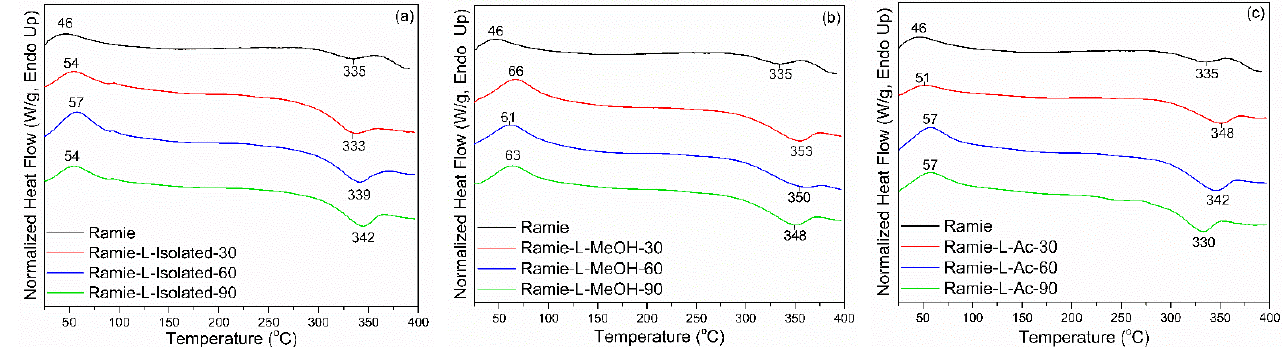
Figure 14. DSC analysis of impregnated ramie fibers: ( a ) Ramie L ‐ Isolated, ( b ) Ramie L ‐ MeOH, and ( c ) Ramie L ‐ Ac.